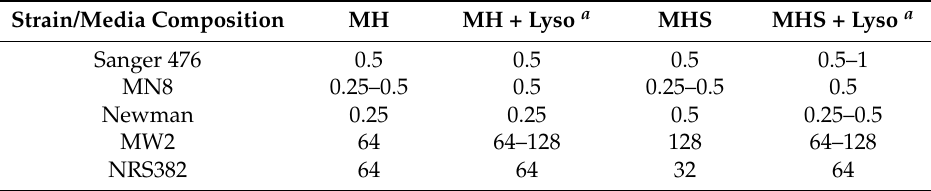
Table 4. Oxacillin MIC measurements summary in µ